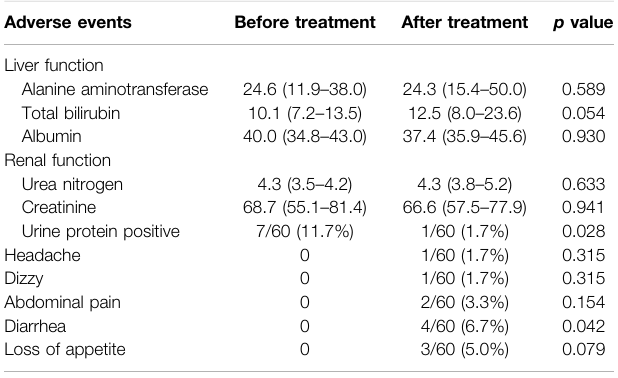
TABLE 4 | YDJDG were evaluated for safety during treatment. Adverse